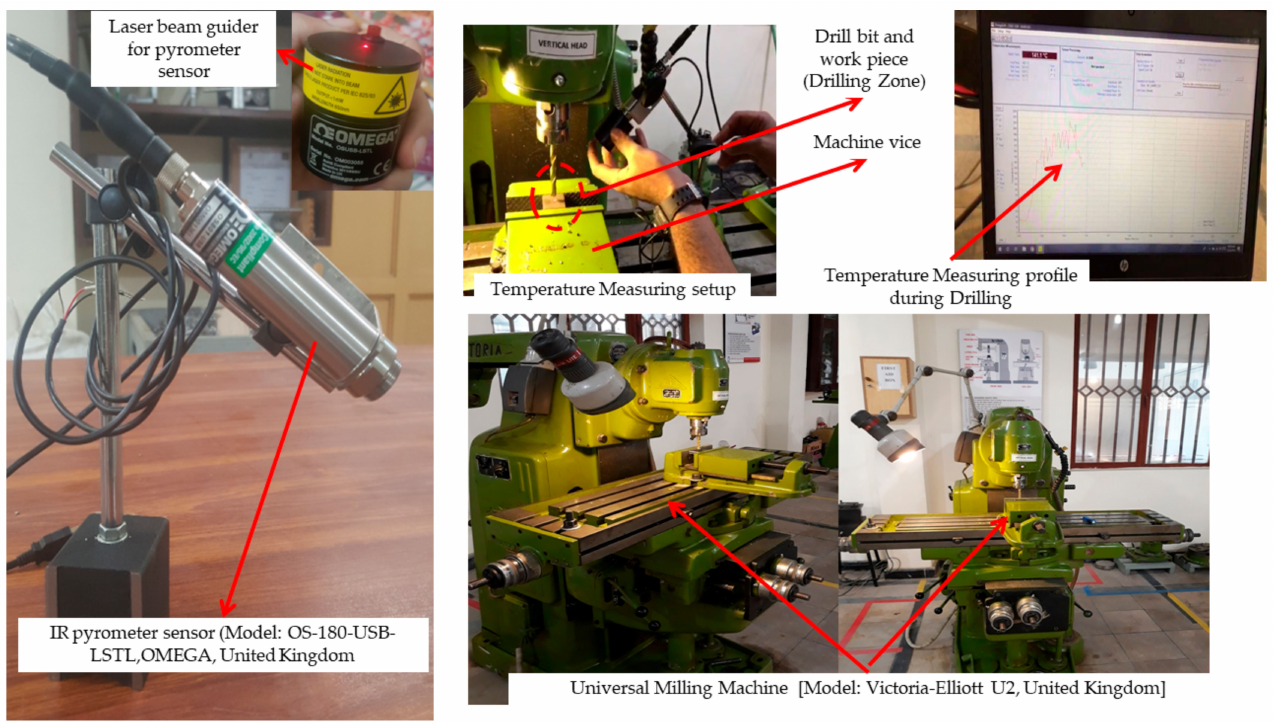
Figure 5. Experimental setup for temperature measurements. For infrared pyrometer, surface emissivity of AISI 1018 mild steel block with relatively rough surface is found experimentally at different temperatures. Prior to noting live temperatures during drilling, the sensor was calibrated for emissivity value. A series